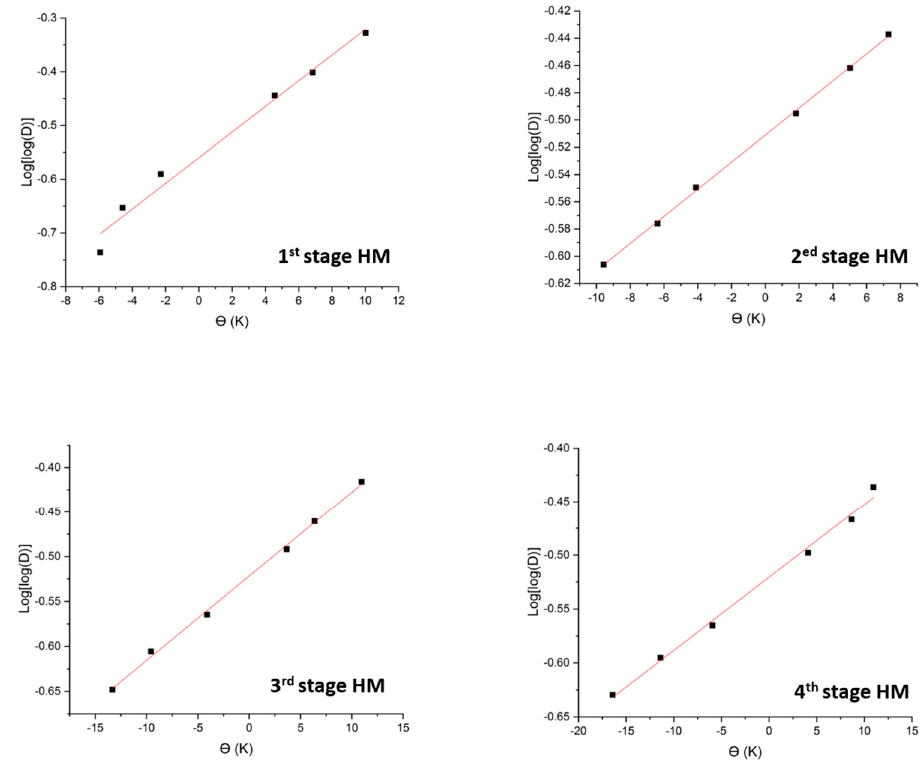
Figure 5. Horowitz–Metzger curves of Mn(II) in different stages.